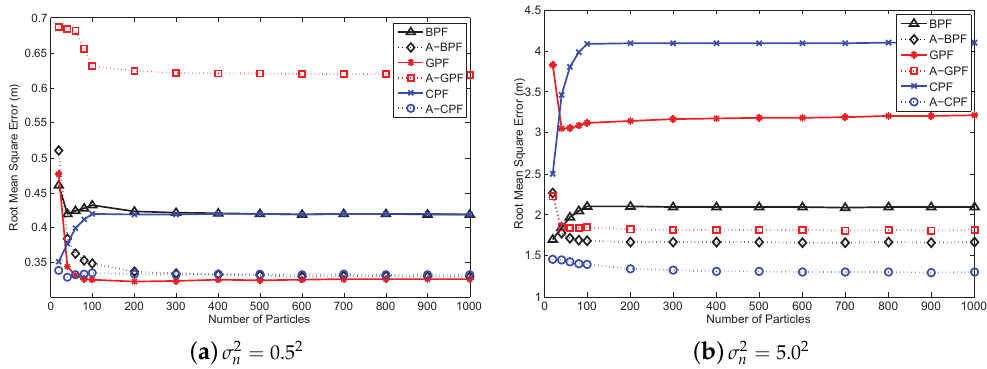
Figure 10. RMSE comparison for different algorithms with different numbers of